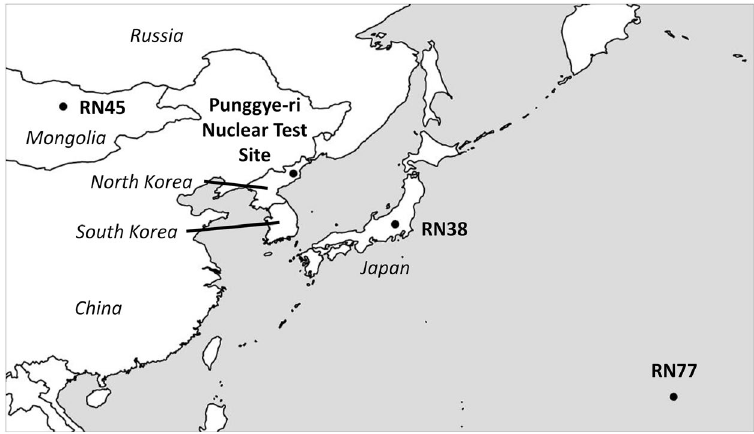
Figure 1. Location of the IMS stations and the Punggye-ri nuclear test site (bullets; text in bold), and the names of the nearby countries (in italic). The map has been generated using ref.